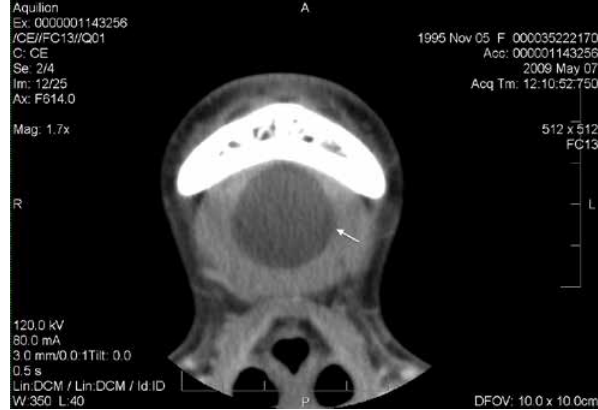
Figure 4: A 15-years old girl. Computed tomography image of the head. The arrow points a cystoid lesion in the submental